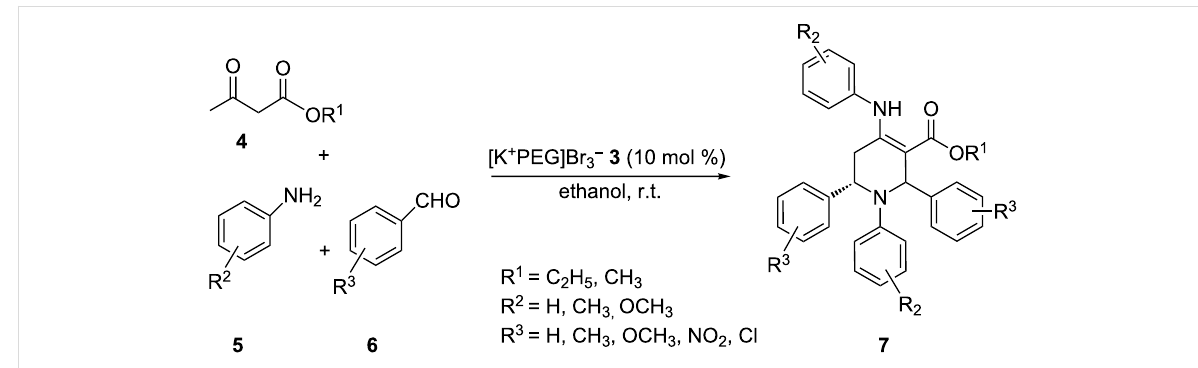
Scheme 2: Synthesis of functionalized